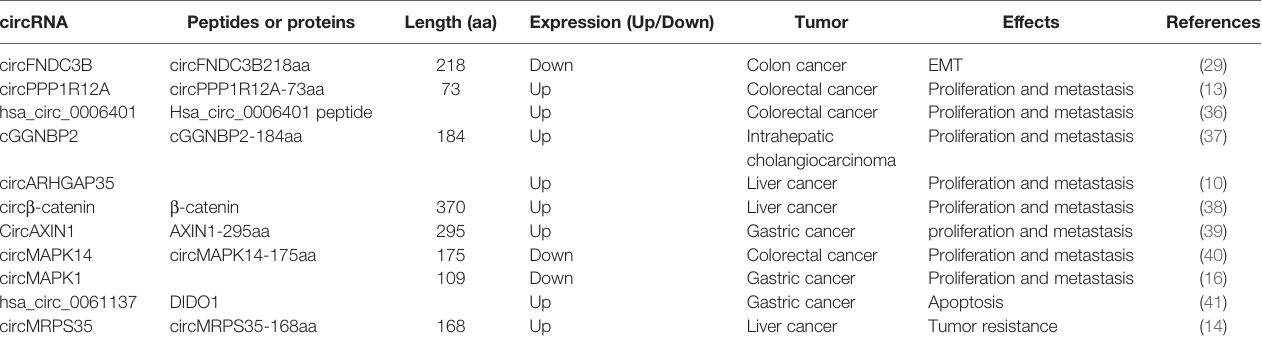
TABLE 1 | Summarsy of peptides encoded by circular RNAs in gastrointestinal